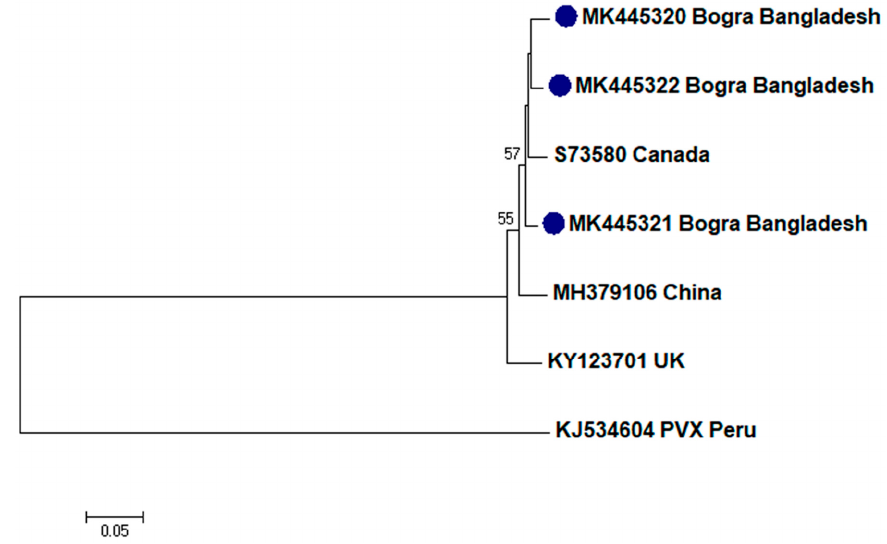
Figure 6. Phylogenetic analysis of Potato aucuba mosaic virus detected from Bangladesh based on the coat protein gene sequences (nt) of different selected isolates from the NCBI database. The phylogenetic tree was generated by MEGA7 using neighbor-joining method with 1000 bootstrap replicates, and only values > 50% are shown at the nodes. An isolate of Potato virus X (PVA) from Peru was used as an